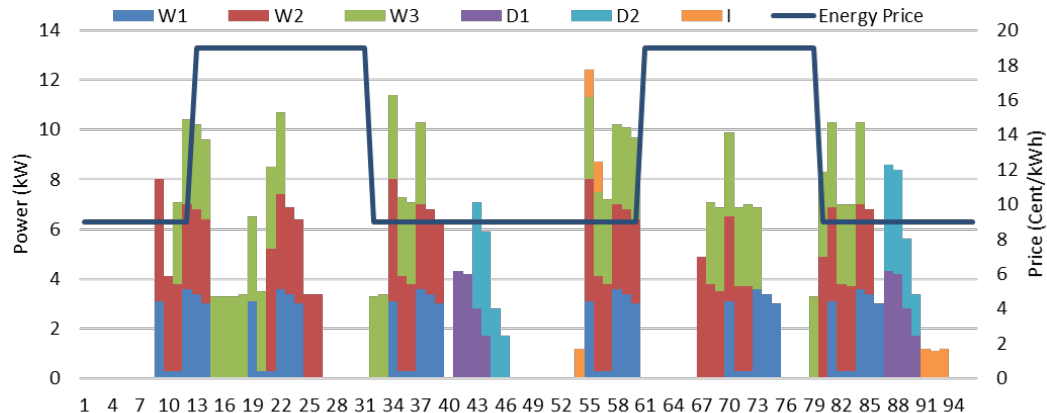
Figure 5. Power consumption of devices in scenario B (based on double-tariff pricing).